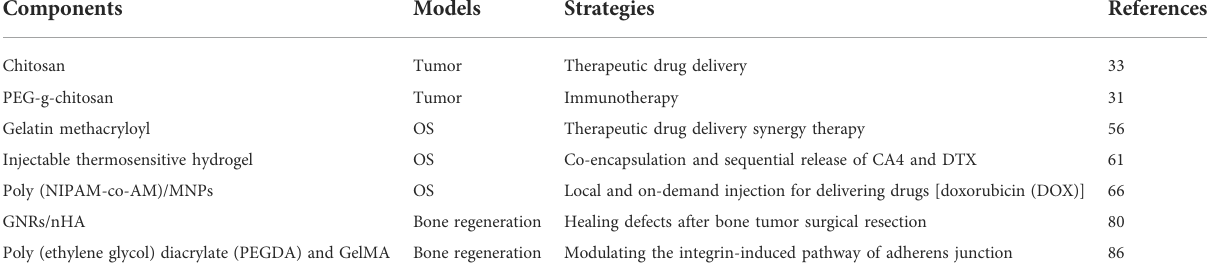
TABLE 1 Recent summary of therapeutic strategies for hydrogel